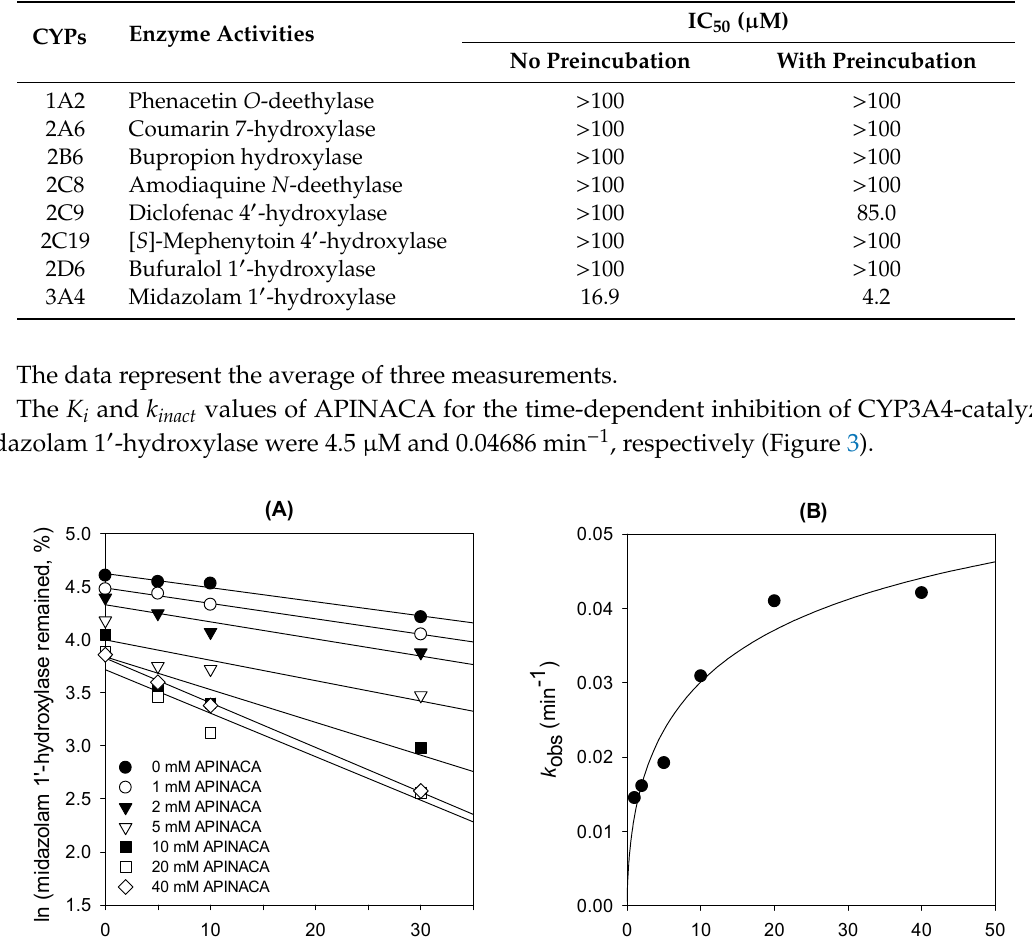
Table 1. Inhibitory potential of APINACA on eight major cytochrome P450 (CYP) enzyme activities with and without a 30-min preincubation in the presence of reduced β -nicotinamide adenine dinucleotide phosphate (NADPH) in ultrapooled human liver microsomes.